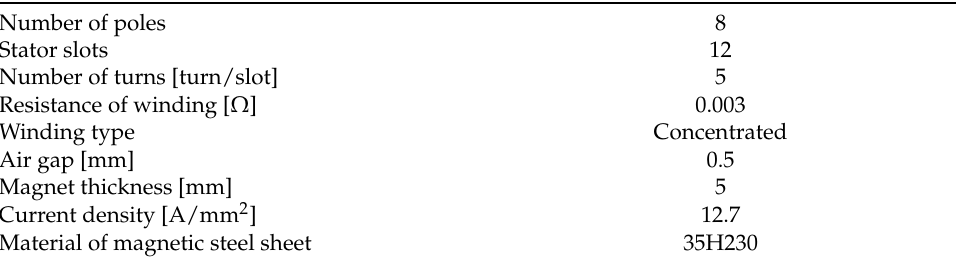
Figure 11. Mises stress of SRM in the rotor at 52,000 min − 1 .